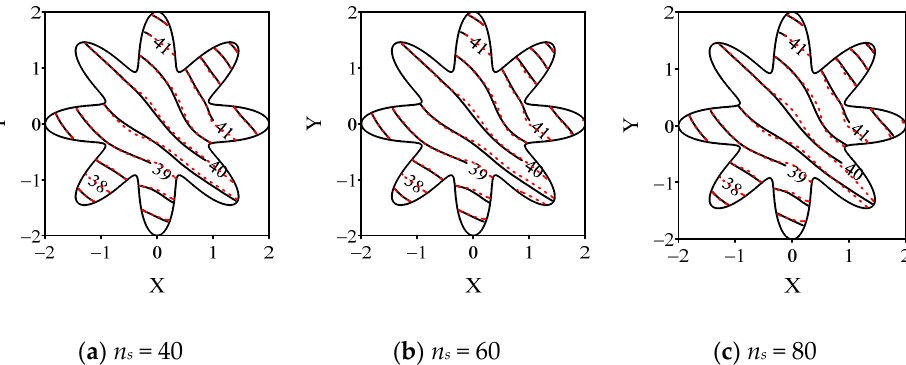
Figure 16. The comparison of numerical solutions of direct problem (solid curve) and inverse problem (dashed curve).